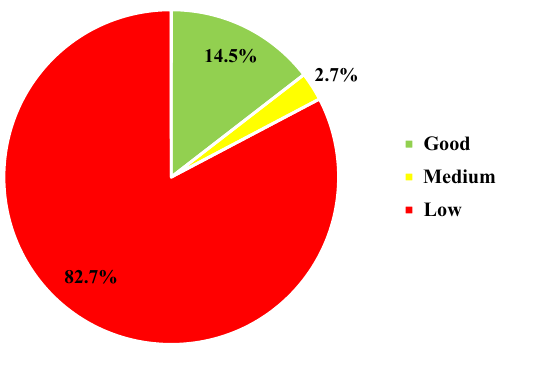
Fig. 11 Assessment of velocities